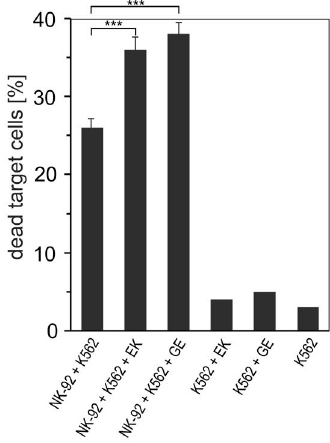
Figure 1. Dipeptides Glu-Lys (EK) or Gly-Glu (GE) enhanced the cy- totoxic effect of NK-92 cells toward K562 target cells. NK-92 cells were incubated overnight with 1 mM dipeptide supplement, and a number of dead target cells was compared to the control samples. The impact of the dipeptides on the target cells is seen as their enhanced death. The data are expressed as mean ± standard deviations (SD) of at least three independent experiments performed in duplicate. A t-test is used to compare the mean of two given samples. P value ( *** ) is below 0.001.